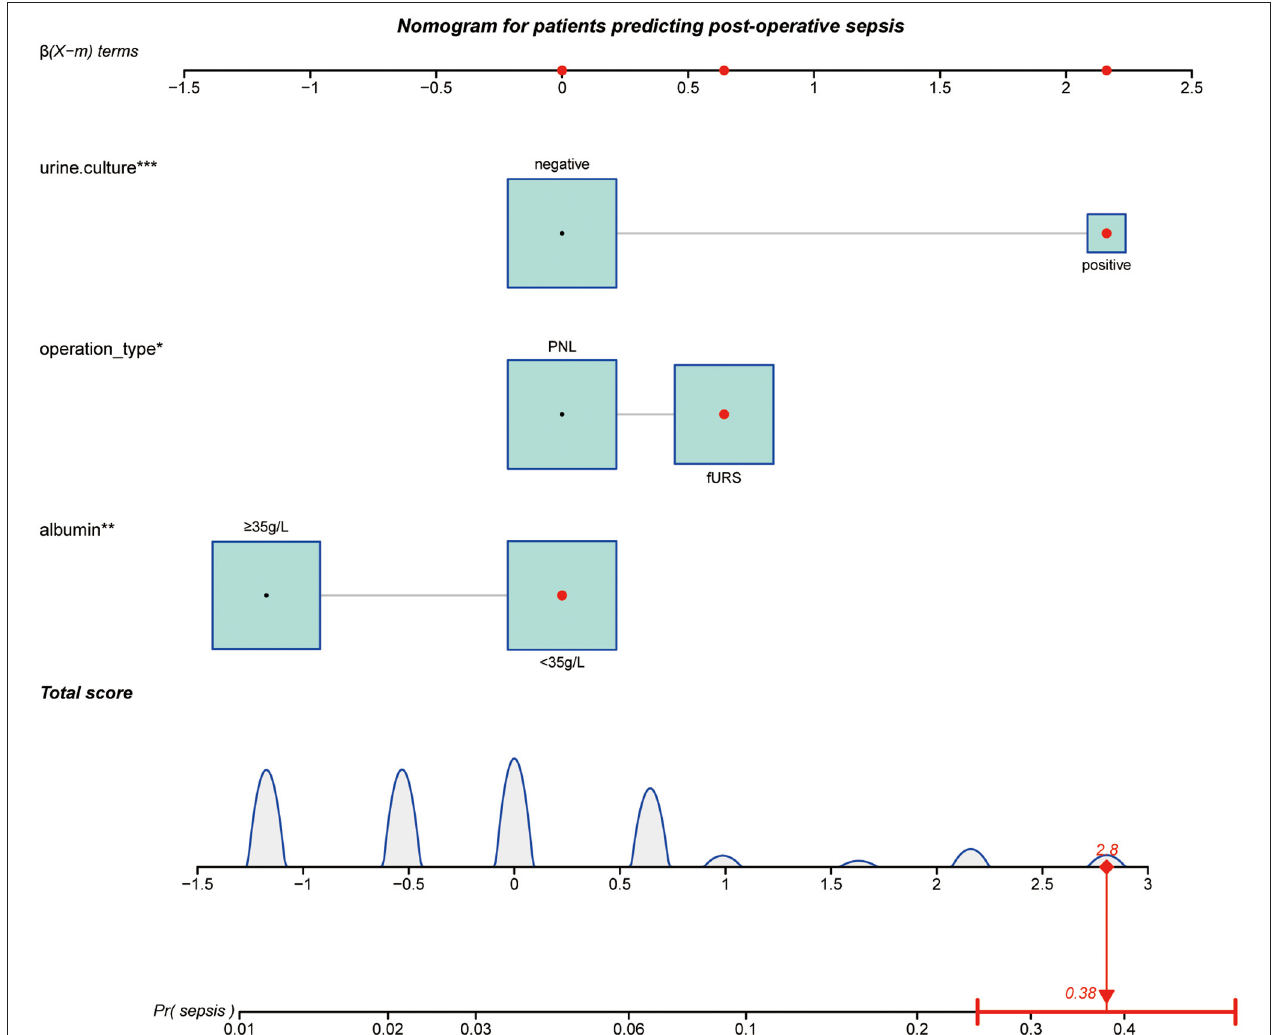
FIGURE 3 | Nomogram for patients predicting postoperative sepsis. Urine culture, operation type, and albumin are marked as “points.” Total points by adding the four points can predict sepsis rate. One patient whose urine culture was positive, operation type was fURS and serum albumin level < 35 g/L was randomly selected for analysis. After adding the score of each item, a total score of 2.8 and the corresponding sepsis rate of 0.38 (95% CI [0.25–0.53]) were obtained. The asterisks represented the statistical p value (* P < 0.05; ** P < 0.01; *** P < 0.001).